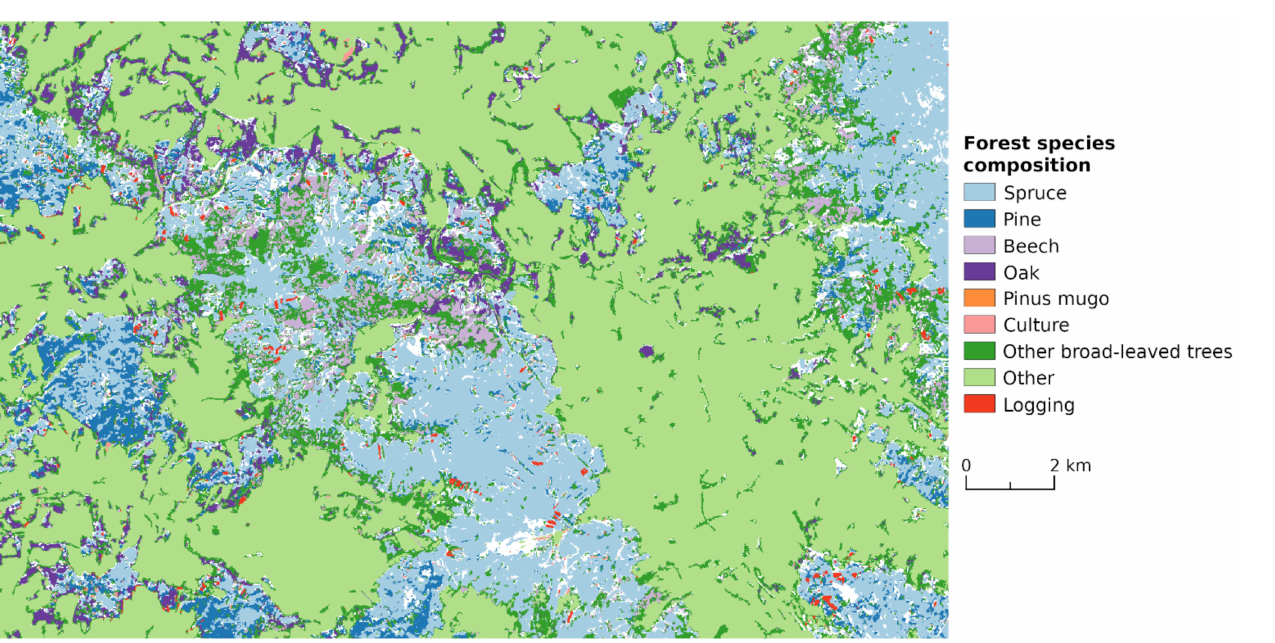
Figure 3. Example of classifications according to forest species